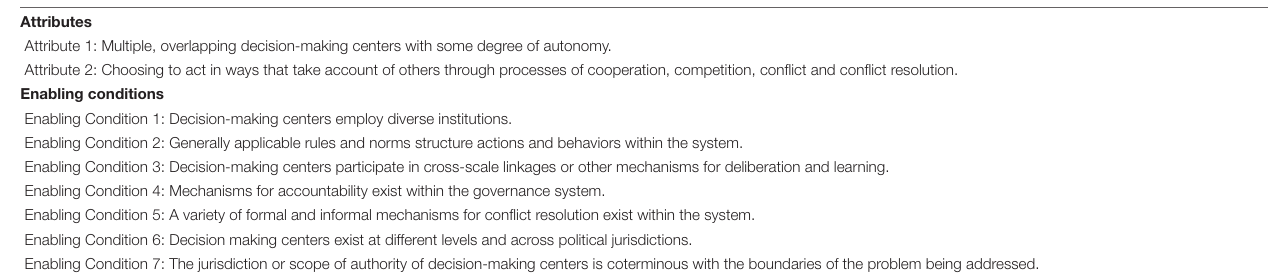
TABLE 1 | Attributes and enabling conditions for functional polycentric governance (Carlisle and Gruby, 2019). Attributes Attribute 1: Multiple, overlapping decision-making centers with some degree of